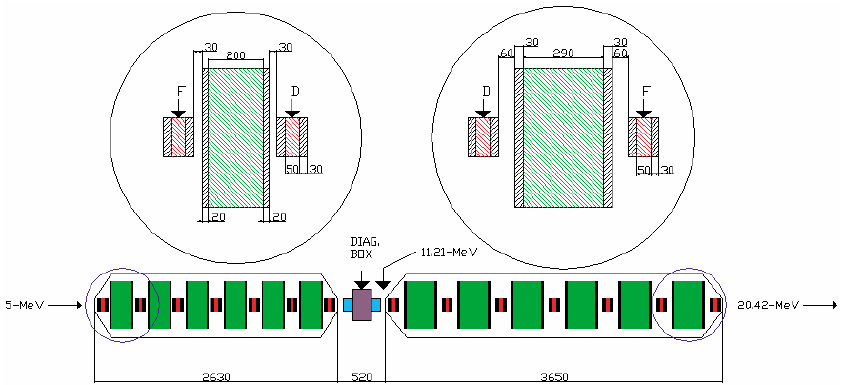
FIG. 2. (Color) Schematic layout of the ISCL (quotes are in mm). The two cryostats house six ladder resonators (in green) of the two families, with sc quadrupoles (in red) in